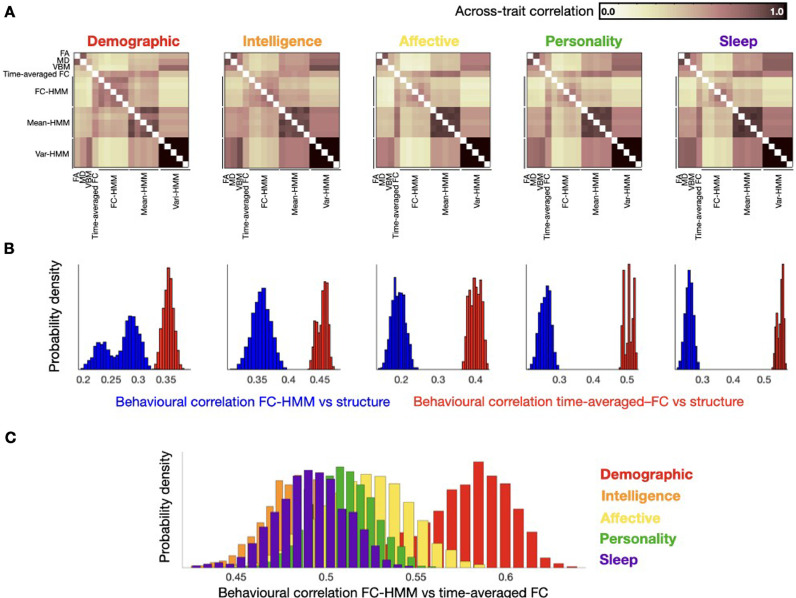
A. How similar are the different representations in explaining behaviour? Similarity matrices (in terms of Pearson's correlation) capturing how similar the prediction of behavioural traits was between each pair of representations are shown for each of the five behavioural groups: time-averaged FC, HMM-based representations including time-varying FC (FC-HMM; used throughout the paper), HMM representations including only changes in amplitude (mean-HMM) or variance (var-HMM), and structural (FA, MD and VBM). B. Distribution densities (obtained via bootstrapping) of between-modality correlations (in terms of explaining behaviour) show that the time-averaged FC representation is more related to the structural representations than the time-varying FC (p<0.001, bootstrap hypothesis testing). C. The correlations between the time-varying and the time-averaged FC representations are higher for the demographic traits than for the other behavioural groups (p<0.001, bootstrap hypothesis testing).